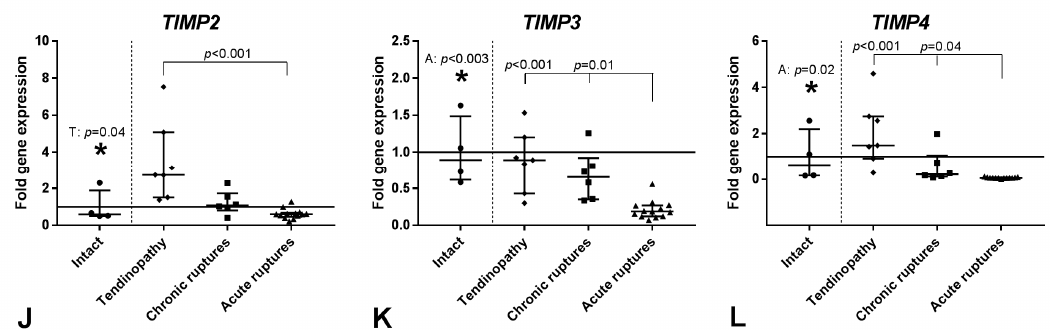
Figure 4. Relative gene expression of collagens ( A – C ), MMPs ( D – H ) and TIMPs ( I – L ) in tendinopathic tendons, chronic ruptures and acute ruptures given as fold to intact tendon tissue (horizontal line, mean value = 1). qRT-PCR data were normalized to the expression of the house keeping gene 18S rRNA with efficiency correction and presented as fold change to the mean of the intact tendons. Results are shown as individual dot plots with median and interquartile range. Significant differences between the intact tendons and the three tendon pathology groups are marked with a star (*) above the intact tendon and the respective significant group (T: tendinopathy, C: chronic ruptures, A: acute ruptures) and the p -value. The vertical dashed line separates the intact group from the tendon pathology groups. Significant differences between the three tendon pathology groups are marked with a spanning line above the groups and the individual p -values. p ≤ 0.05 was considered as statistically significant.